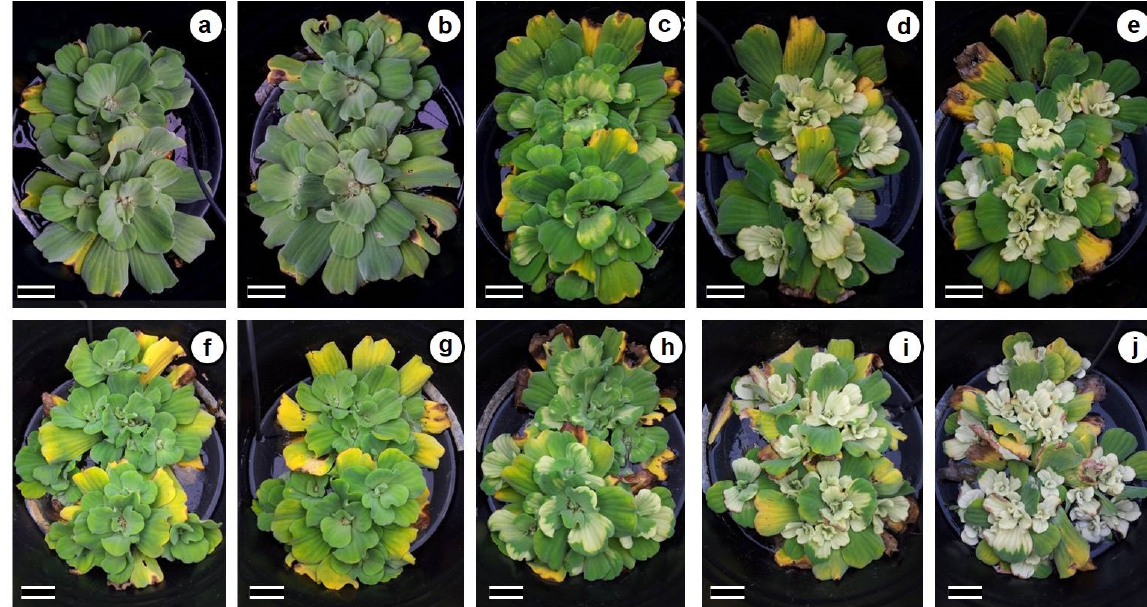
Figure 2. Pistia stratiotes injuries observed at 21 ( a - e ) and 45 ( f - j ) days after clomazone application. a and f .